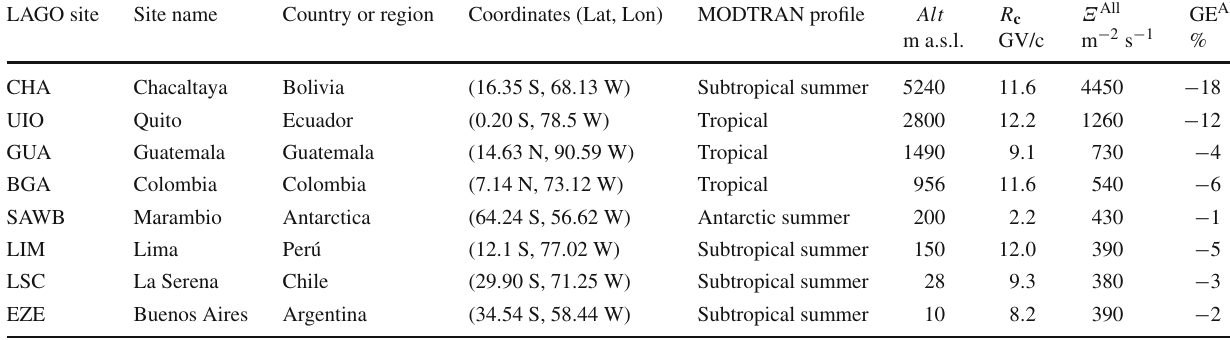
Table 1 The estimated flux of cosmic background radiation at ground level for eight LAGO sites: Chacaltaya, Quito, Guatemala, Bucara- manga, Marambio Base, Lima, La Serena, and Buenos Aires, char- acterized by their geographical coordinates, atmospheric profiles and